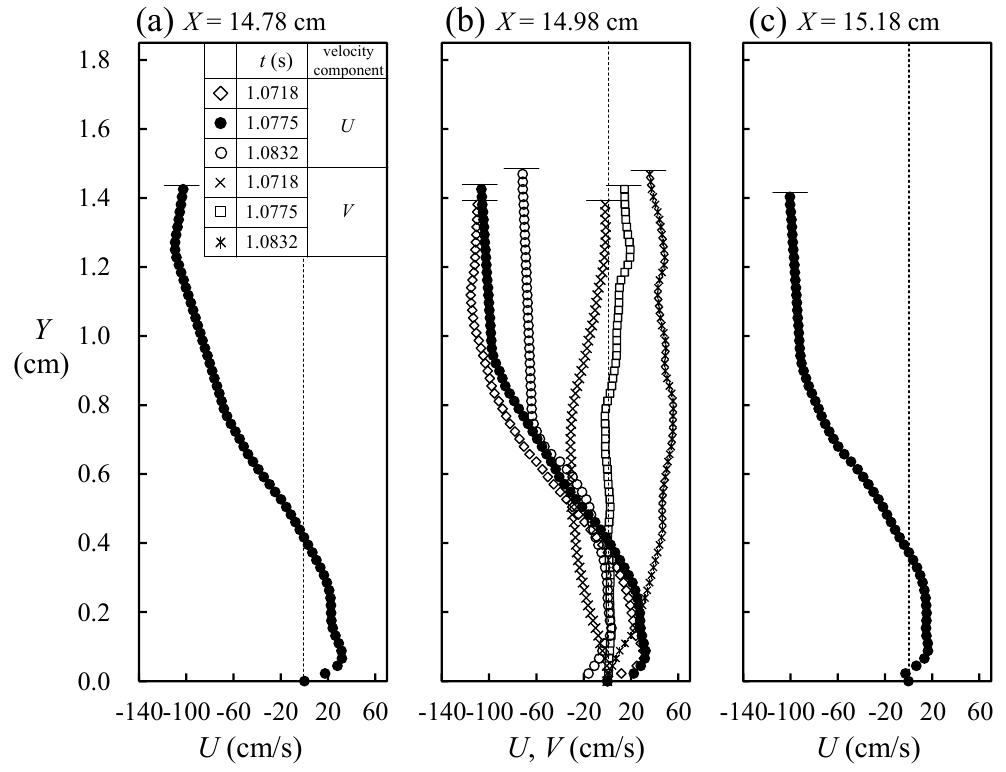
Figure 19. ( a – c ) The velocity profiles U ( Y ) measured at X = 14.78, 14.98 and 15.18 cm for t = 1.0775 s, respectively. Note that two velocity profiles, U ( Y ), for t = 1.0718 and 1.0832 s as well as three velocity profiles, V ( Y ), at t = 1.0718, 1.0775 and 1.0832 s are also included in ( b ).